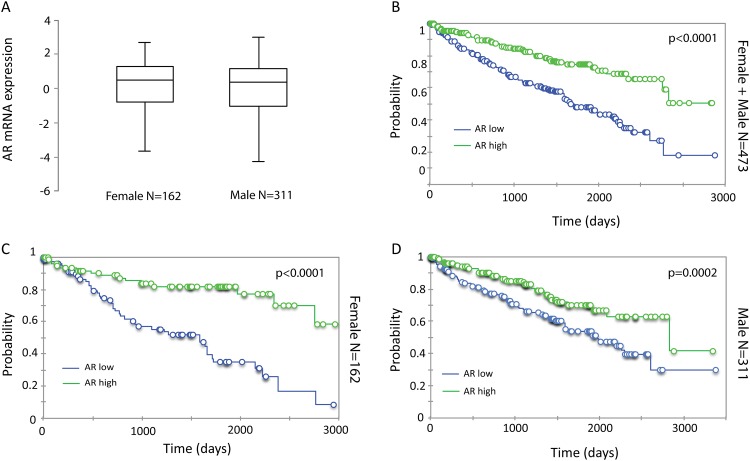
mRNA expression of AR and its association with survival in ccRCC.(A) Box plot of log2 transformed and mean centered AR mRNA levels in females and males. No significant difference was observed by student’s t-test. (B-D) Kaplan-Meier analysis of AR mRNA expression and overall survival in all cases (B), females (C) and males (D).